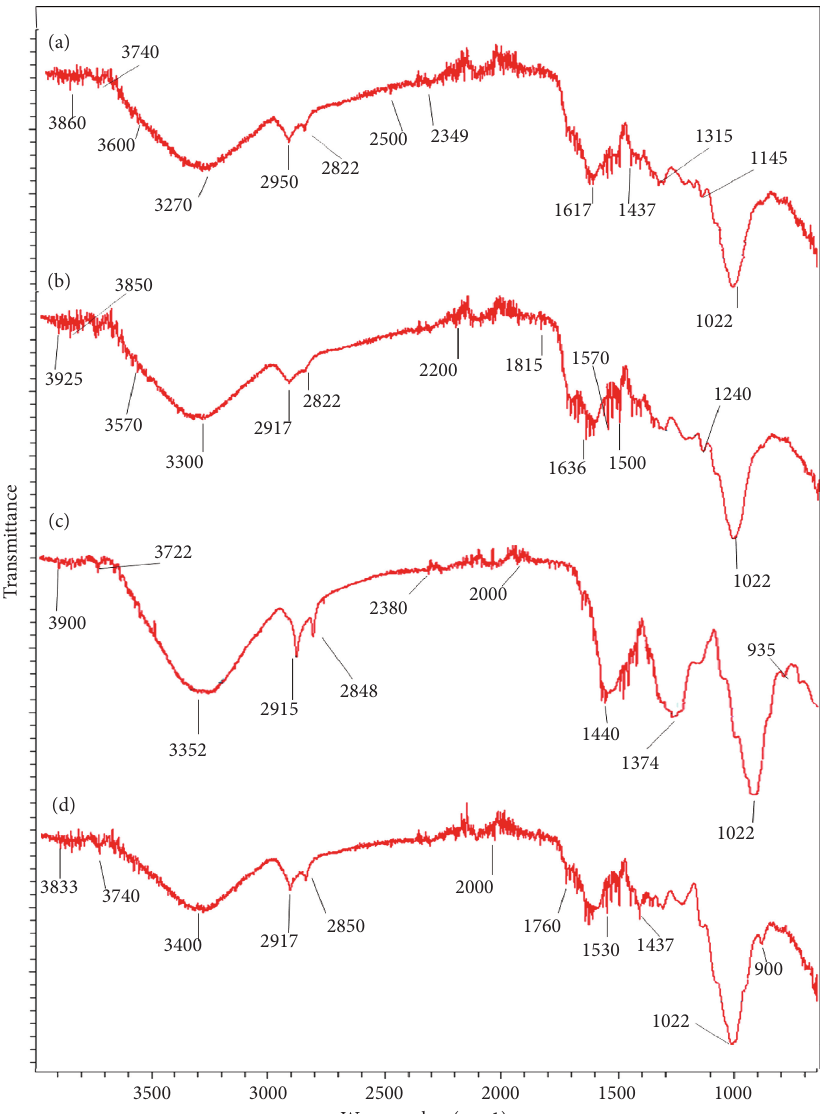
Figure 5: FTIR spectra of untreated and citric acid-treated peels after the adsorption of dye (BGD). (a) BGD-R-TNP, (b) BGD-CA- TNP, (c) BGD-R-CLP, and (d)